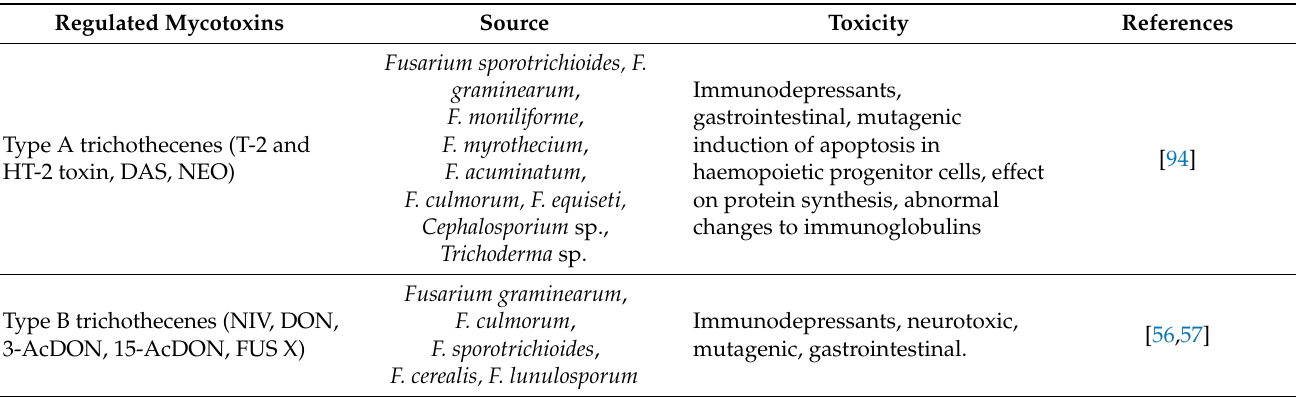
Table 2. Regulated trichothecenes and their toxicity